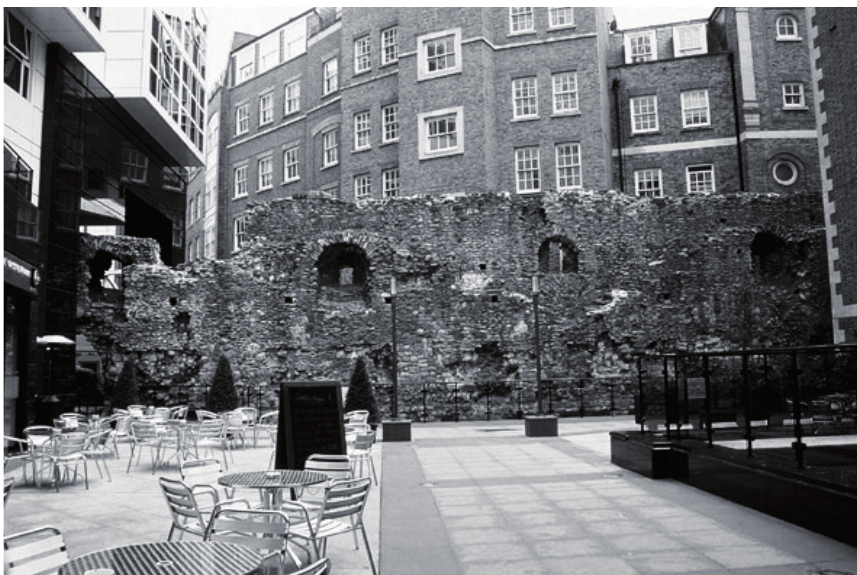
Figure 3. City Wall, Cooper´s Row, London (Photo by C.